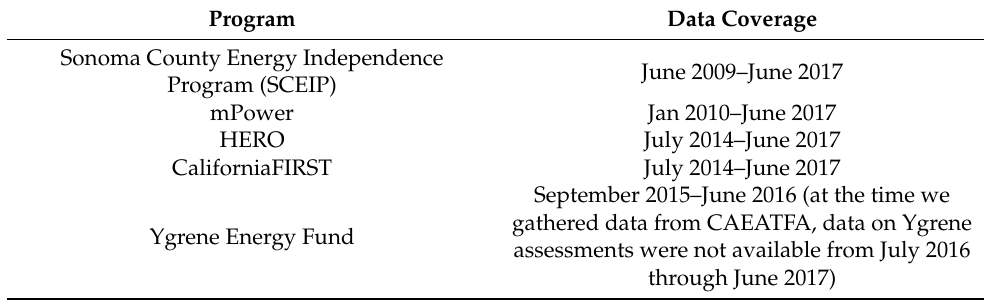
Table 1. California R-PACE program